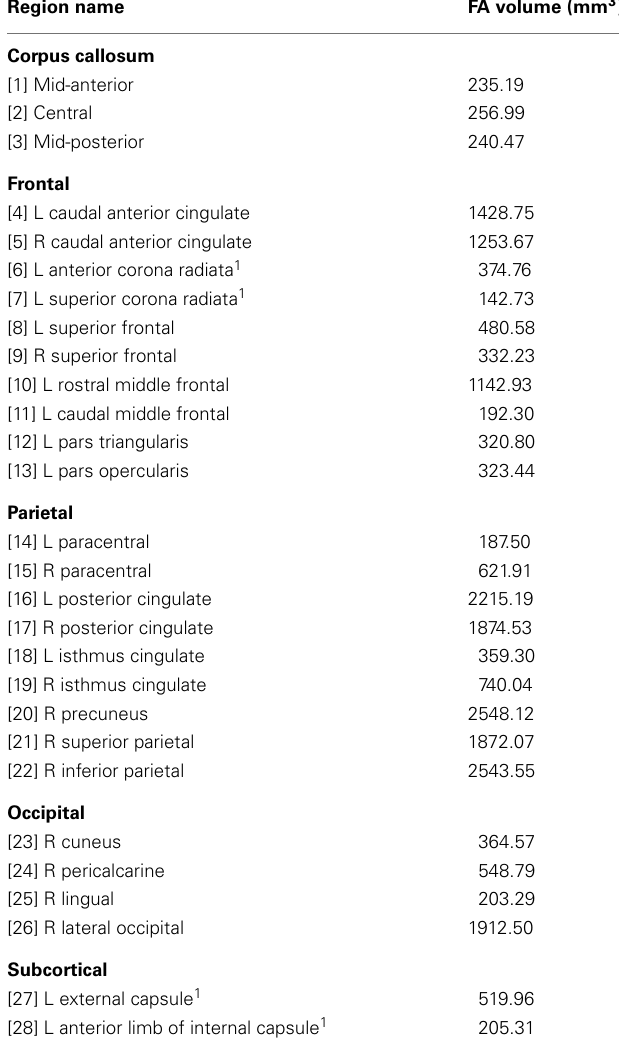
Table 3 | Regions of interest (ROI) derived from voxelwise tests of group